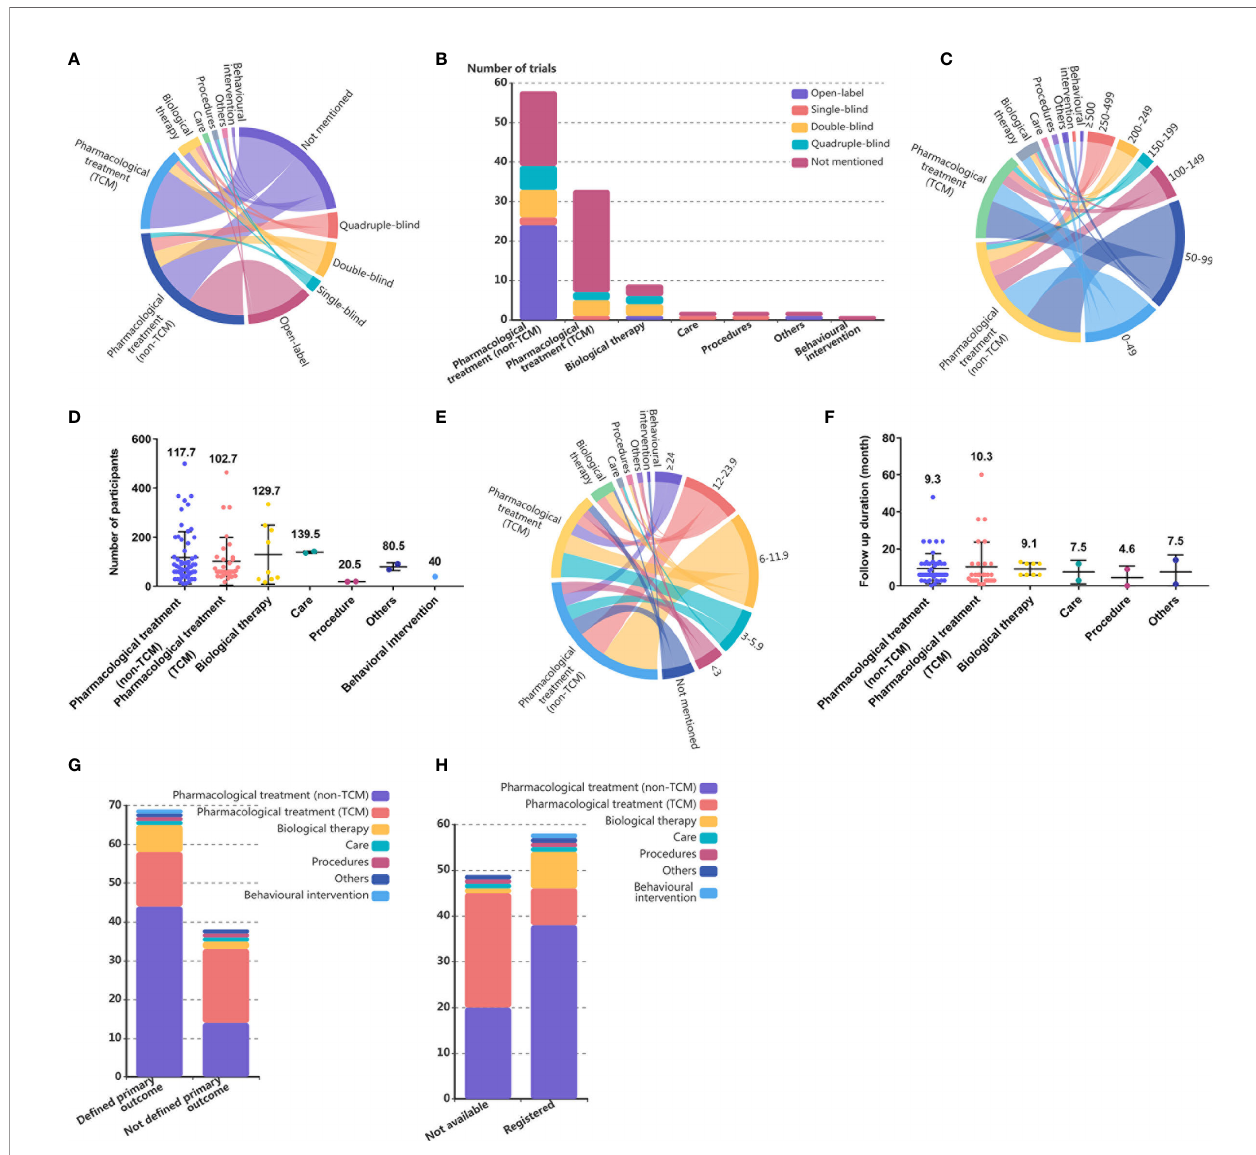
FIGURE 2 | Study design of single country SLE RCTs in mainland China. (A) Chordal diagram of masking status of RCTs by intervention categories in SLE RCTs conducted in mainland China. The masking status and intervention categories each account for half of the circumference of the circle, with a longer arc length indicating more RCTs and a thicker line connecting the country and sample sizes indicating more RCTs. (B) Number of RCTs in SLE by intervention categories and masking status. (C) Chordal diagram of sample sizes of RCTs by intervention categories in SLE RCTs conducted in mainland China. The sample sizes and intervention categories each account for half of the circumference of the circle, with a longer arc length indicating more RCTs and a thicker line connecting the country and sample sizes indicating more RCTs. (D) Number of participants in SLE trials by intervention categories. Each dot represents one trial, and the value above dots represents the mean number of participants of one trial in each intervention category. (E) Chordal diagram of intervention duration in RCTs by intervention categories in SLE RCTs conducted in mainland China. The intervention duration and intervention categories each account for half of the circumference of the circle, with a longer arc length indicating more RCTs, and a thicker line connecting the country and sample sizes indicating more RCTs. (F) Number of RCTs in SLE by intervention categories and follow up duration. Each dot represents one trial, and the value above dots represents the mean follow-up duration of one trial in each intervention category. (G) Number of RCTs in SLE by intervention categories and primary outcome de fi nition. (H) Number of RCTs in SLE by intervention categories and